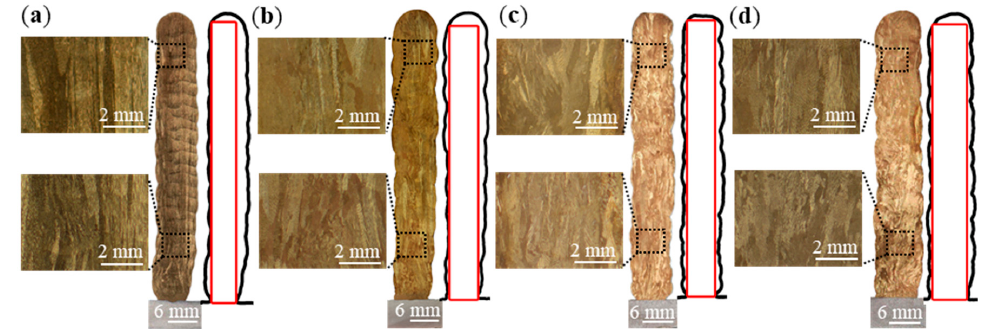
Figure 2. Morphology of Cu-8Al-2Ni-Fe-2Mn alloy with different parameters (Y-Z plane) and effective area: ( a ) sample C2, ( b ) sample C3, ( c ) sample U2, ( d ) sample U3. (The macro image on the left is an enlarged view of the position in the black dotted box).